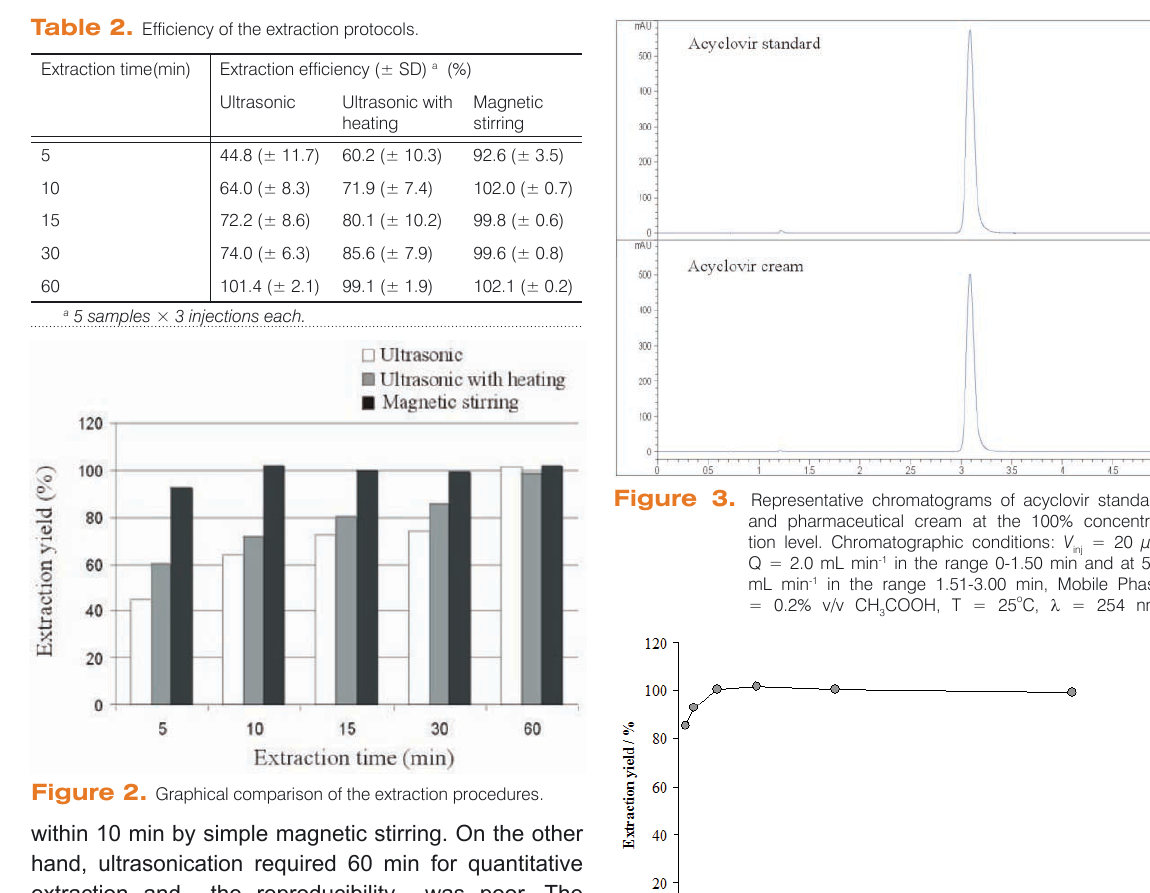
Table 2. Efficiency of the extraction protocols.